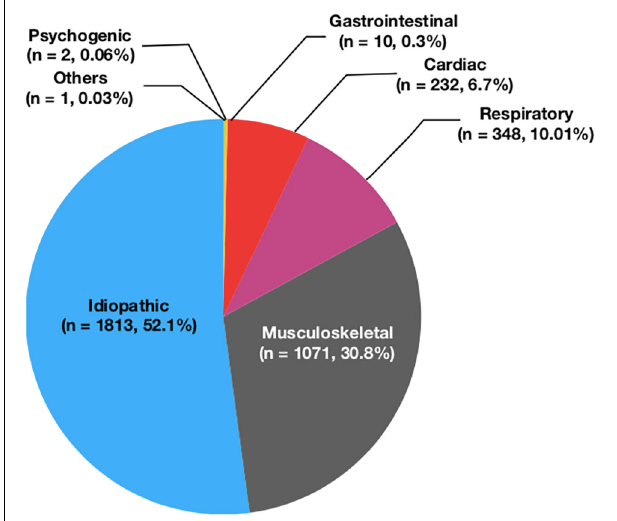
FIGURE 2 | The disease composition of chest pain in children admitted to cardiac clinic.